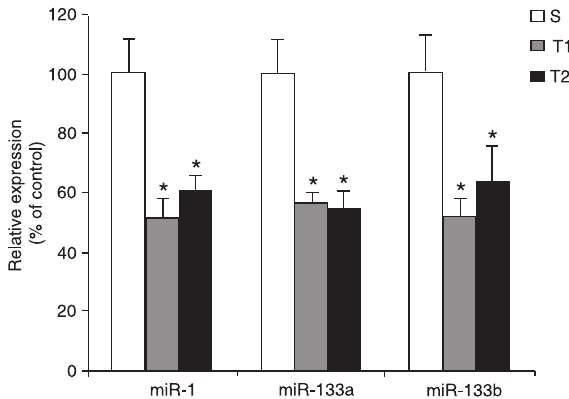
Figure 3. Effect of exercise training on relative expression of car- diac miR-1, miR-133a and miR-133b analyzed by real-time PCR. miR = microRNA; S = sedentary Wistar rats; T1 = rats trained by swimming sessions for 10 weeks, 60 min per session, 5 days per week; T2 = similar to T1 until the end of the 8th week; in the 9th week rats swam two sessions per day and in the 10th week they swam three sessions per day. *P < 0.01 compared to S rats (one- way ANOVA and Tukey post hoc test). N = 5 animals/group. Data are reported as means ± SD. miR =